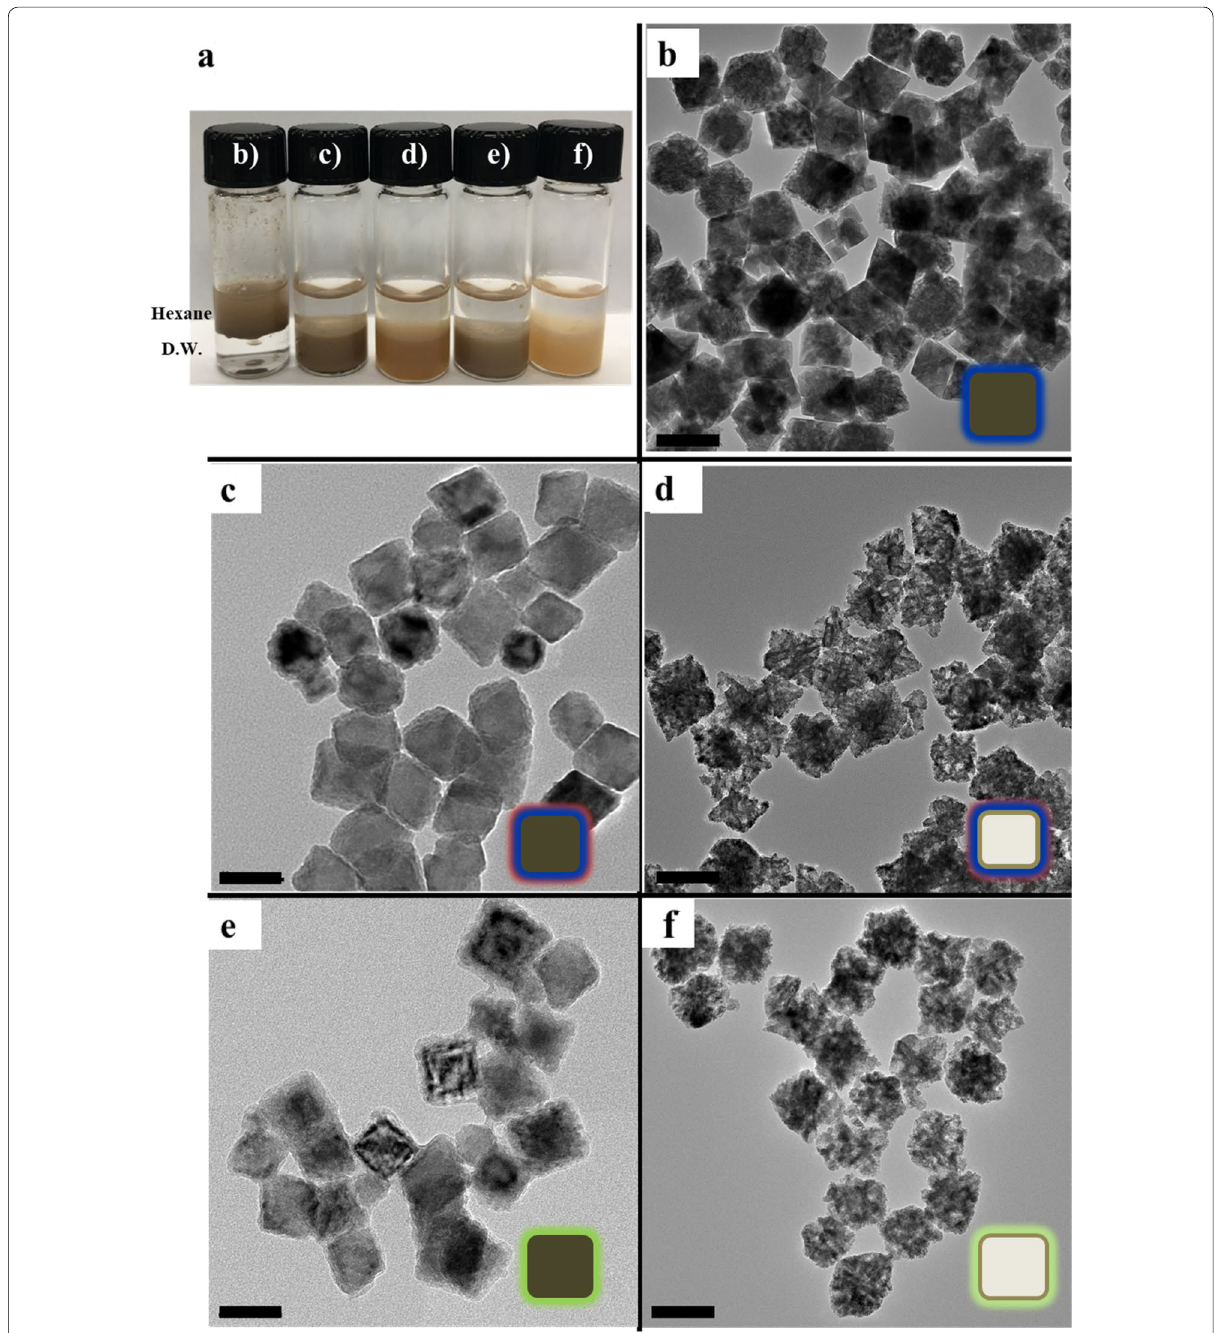
Fig. 2 a Photos of the dispersibility of MnO in oil phase (hexane) and each MnO nanocube in aqueous phase (D.W.). TEM images of b MnO, c MnOEn, d MnOEnHo, e MnOEx, and f MnOExHo (scale bar: 50